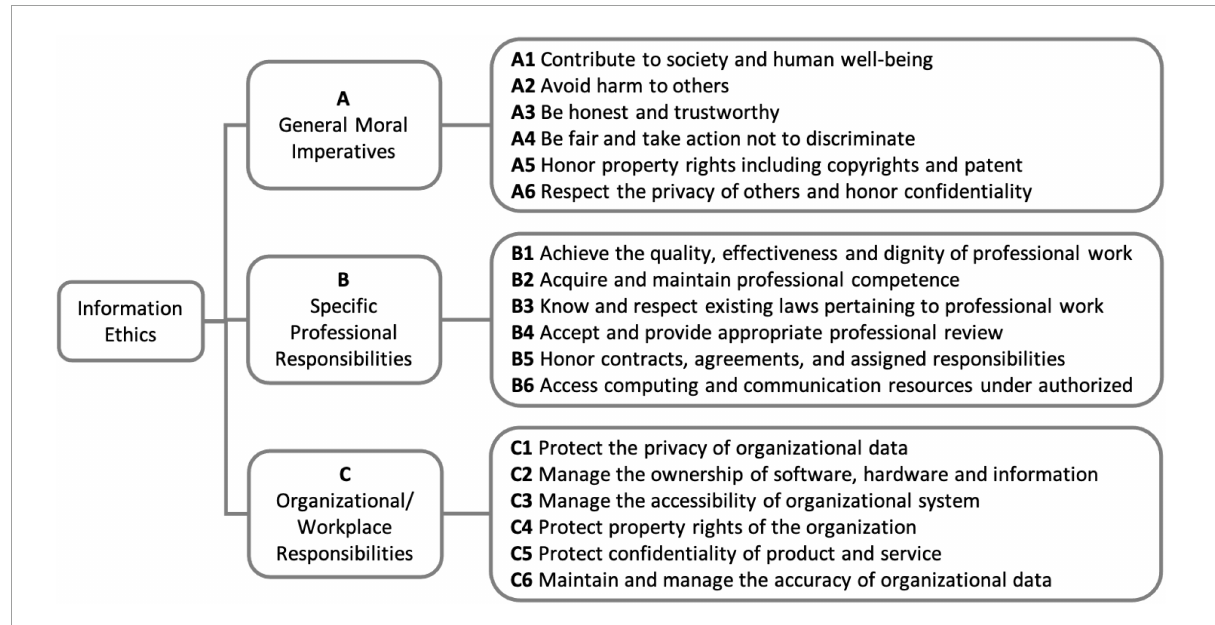
FIGURE1 The analytical hierarchy of information